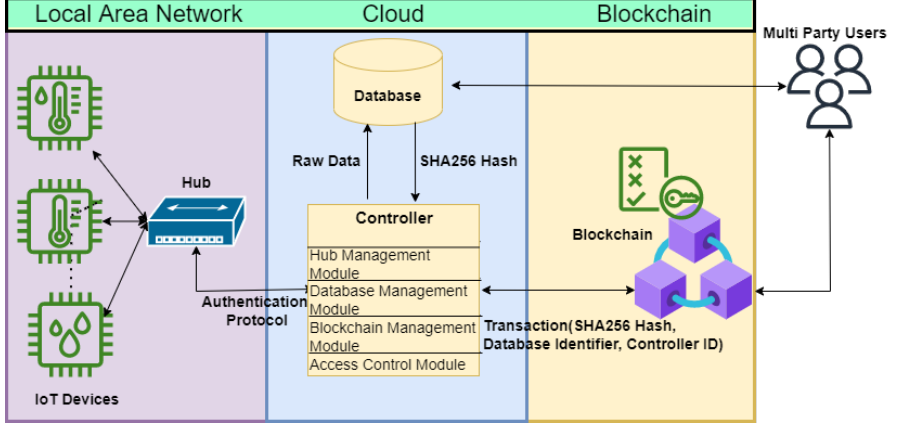
Figure 1. System